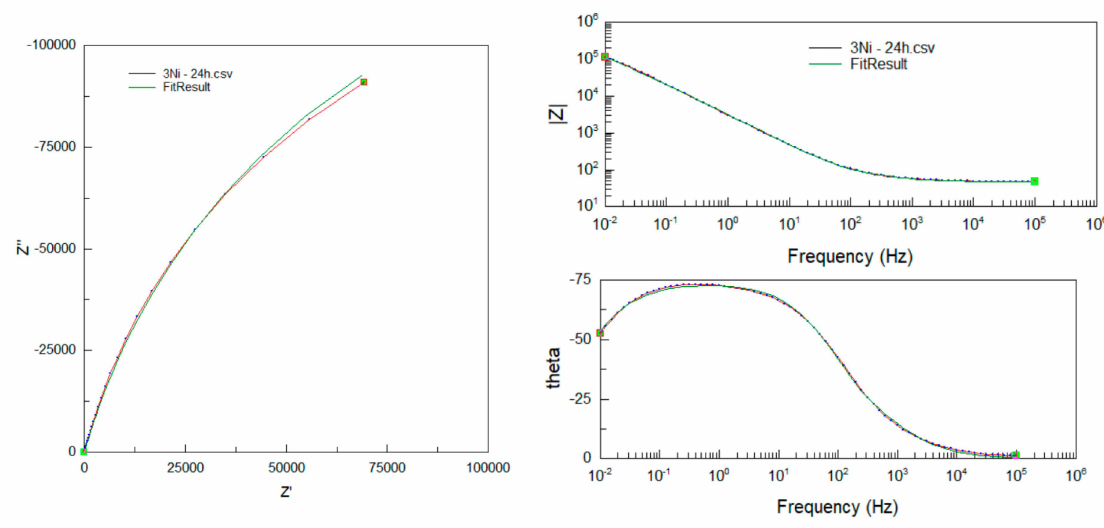
Figure 10. Adjustment of the experimental data of the Fe40Al-3Ni intermetallic with the proposed equivalent